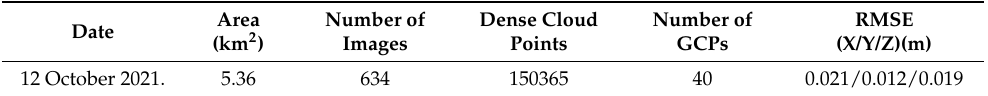
Figure 13. Comparison of the satellite and UAV images: ( a ) UAV image based on SfM-MVS (31 October 2021); ( b ) satellite image acquired from Google Earth (12 October 2021). Table 3. Summary of the parameters in